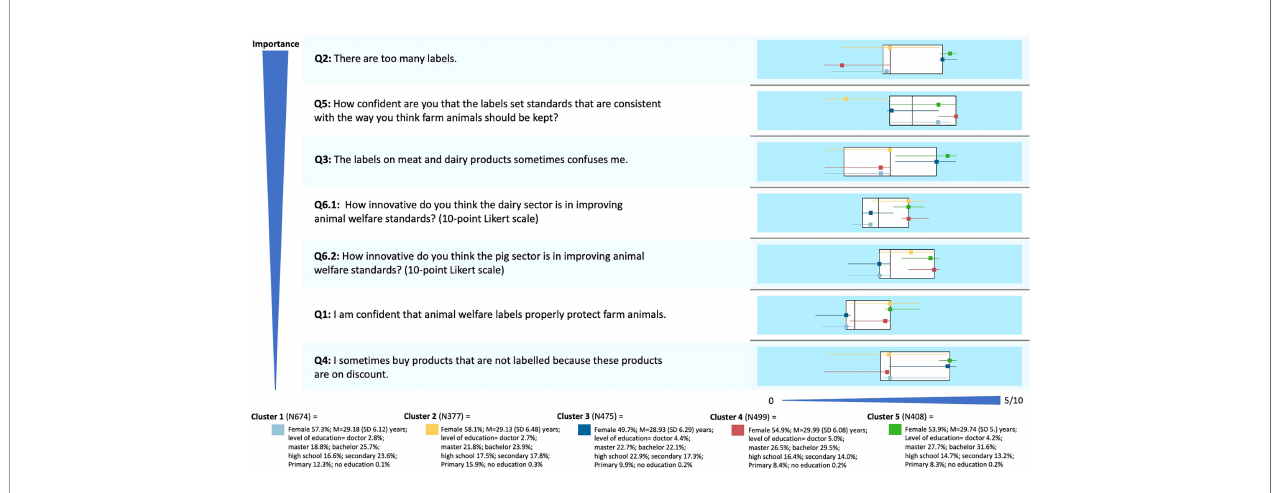
FIGURE 2 | Cross-national results of the consumer